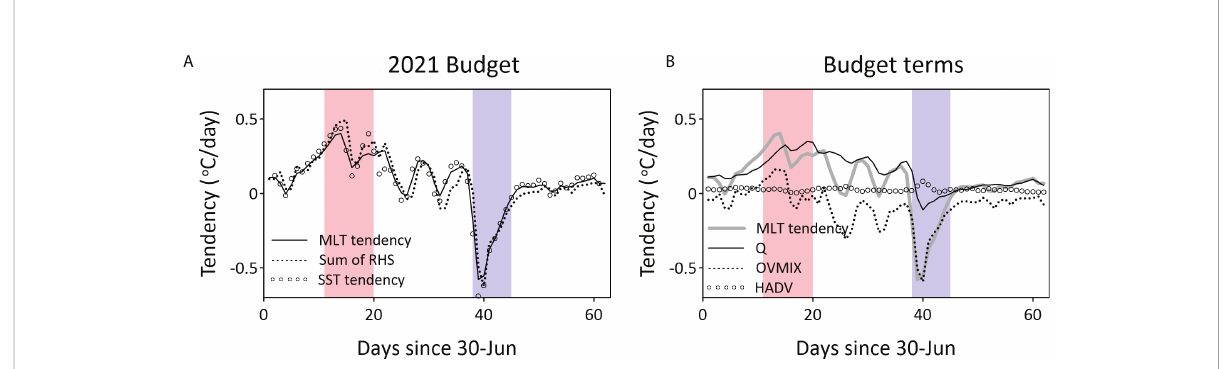
FIGURE 7 Time series plots illustrating the (A) mixed-layer temperature (MLT) tendency (solid line), sum of tendency budget terms (dotted line), and sea surface temperature (SST) tendency (circles), and (B) MLT tendency due to surface heat fl ux (Q; solid line), ocean vertical mixing and entrainment/detrainment terms (OVMIX; dotted line), and horizontal advection (HADV; circles) overlaying with MLT tendency (thick gray line) in the total (TOT) mid-latitude in the western North Paci fi c